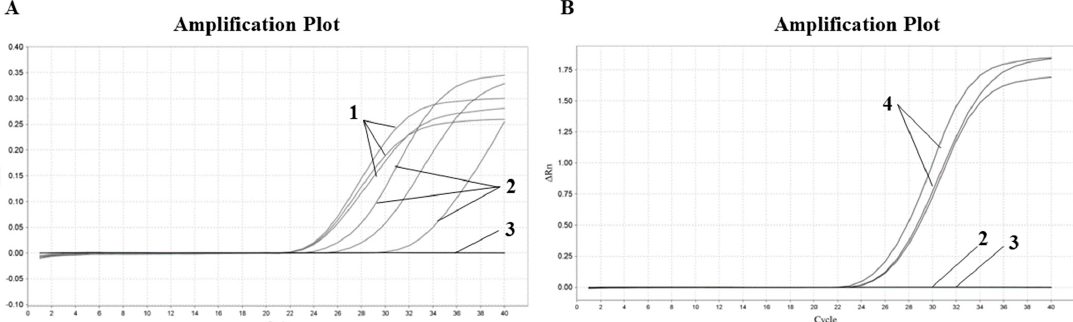
Figure 4. Proofman–LMTIA method for testing Mengniu pure cow milk. ( A ): Verification of cow milk DNA: 1: beef gDNA; 2: cow milk DNA; 3: ddH 2 0; ( B ): Detection of soybean-derived compo-